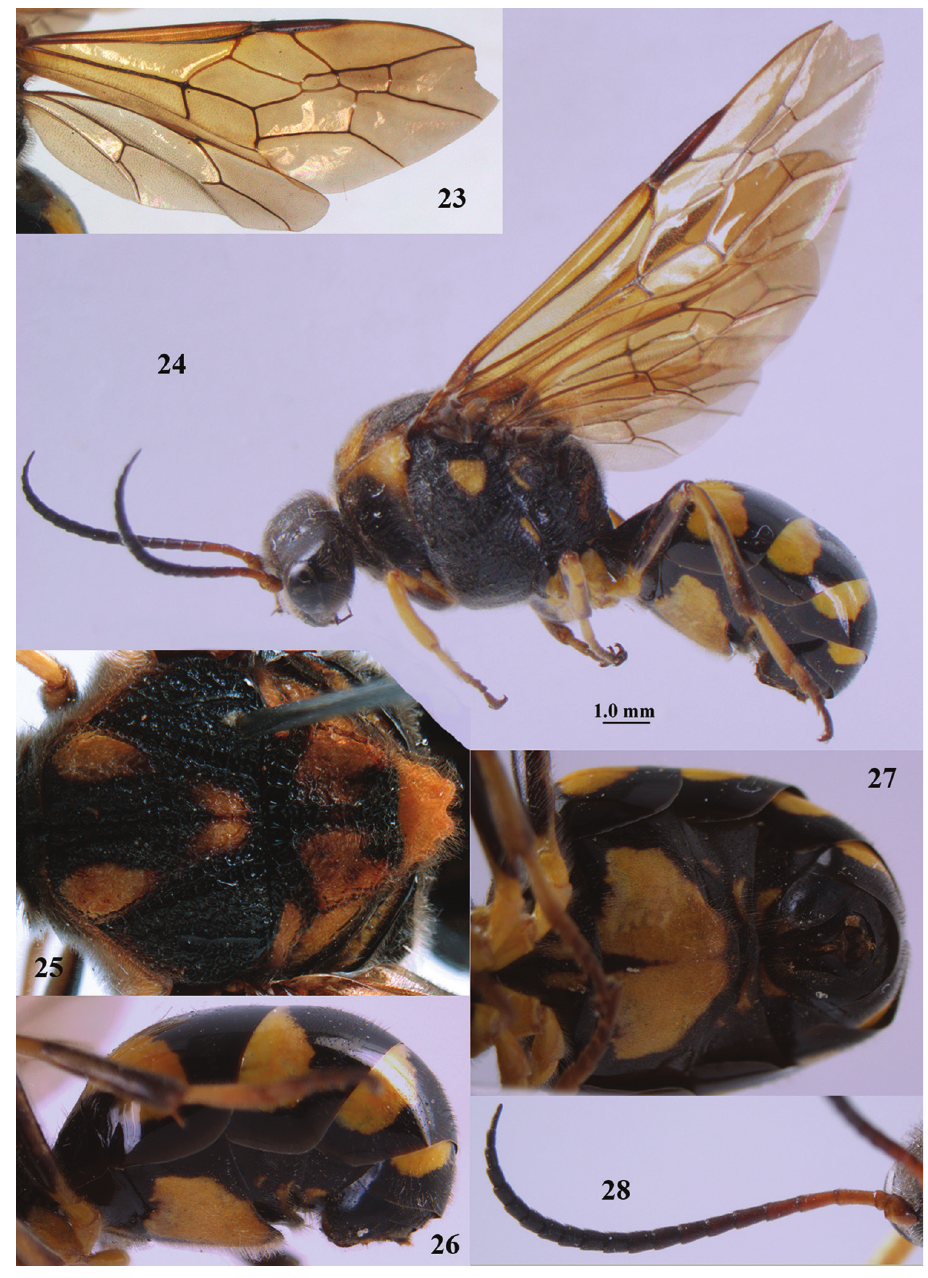
Figures 23–28. Bareogonalos jezoensis , female, Japan (Kyushu, Kobayashi). 23 wings 24 habitus lateral 25 mesosoma dorsal 26 metasoma lateral 27 metasoma ventral 28 antenna